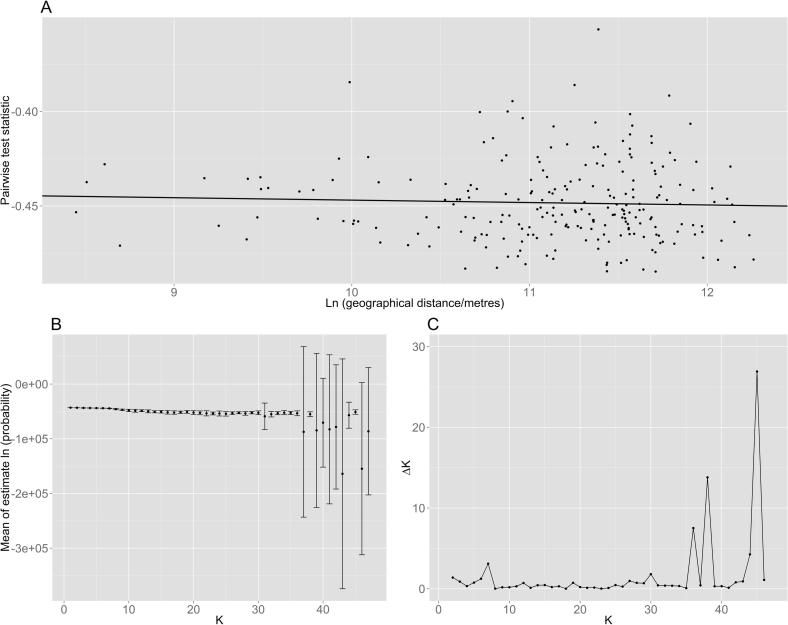
Results of tests for isolation by distance and population structuring within Fasciola hepatica from Great Britain. (A) Isolation by distance results for F. hepatica parasites from cattle. Each point plots the genetic difference (pairwise test statistic based on FST/[1 − FST]) against the geographical distance (on a natural logarithm (Ln) scale) between each pair of populations. Each population consists of the parasites on one farm; comparisons are not made between parasites on the same farm. The regression line is shown and has the following parameters: slope = −0.00129 (95% confidence interval = −0.00317, 0.00142); intercept = −0.434; P = 0.2968. Therefore, there is no evidence of isolation by distance as the slope is negative and the P value non-significant. (B) Structure (Pritchard et al., 2000) was used to detect population structure. K represents the number of populations assumed for each simulation and is plotted against the mean natural log probabilities. Each simulation was repeated 20 times and error bars show the SDs. (C) To determine the most appropriate value for K, ΔK (the rate of change in the log probability between successive K values; Evanno et al., 2005) was determined using Structure Harvester (Earl and vonHoldt, 2012). The results indicate a single population with no structure.